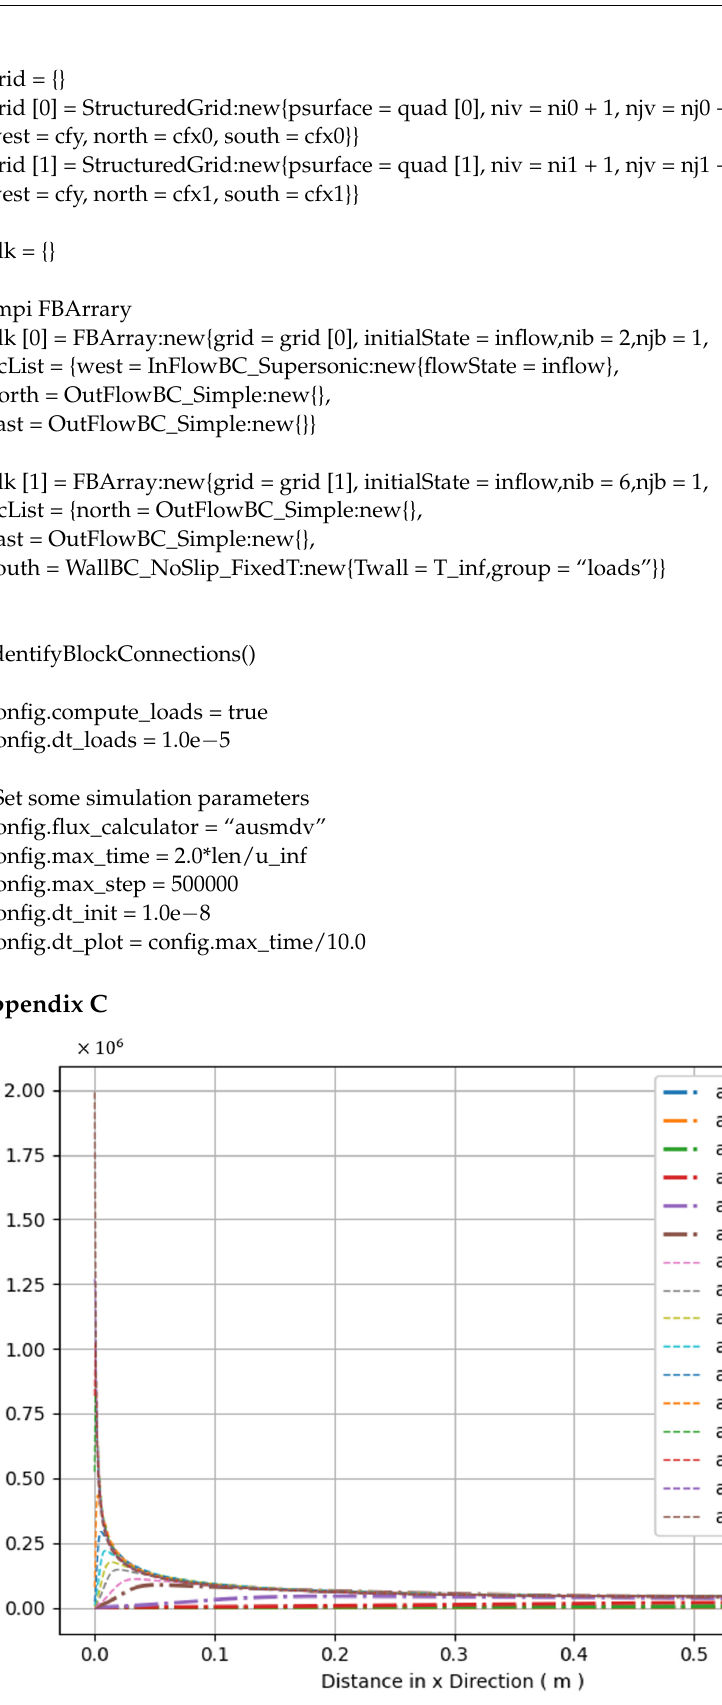
( b ) ( c ) Figure A2. Entropy profile of s00: ( a ) laminar model; ( b ) SA model; ( c ) SA-BCM model.